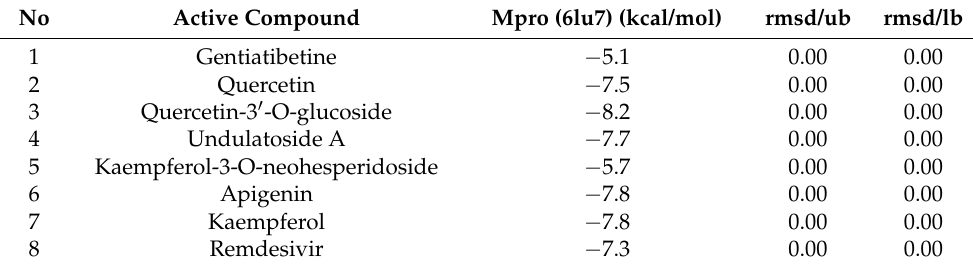
Table 3. The best binding energy scores of the active compounds and the target proteins of Mpro. No Active